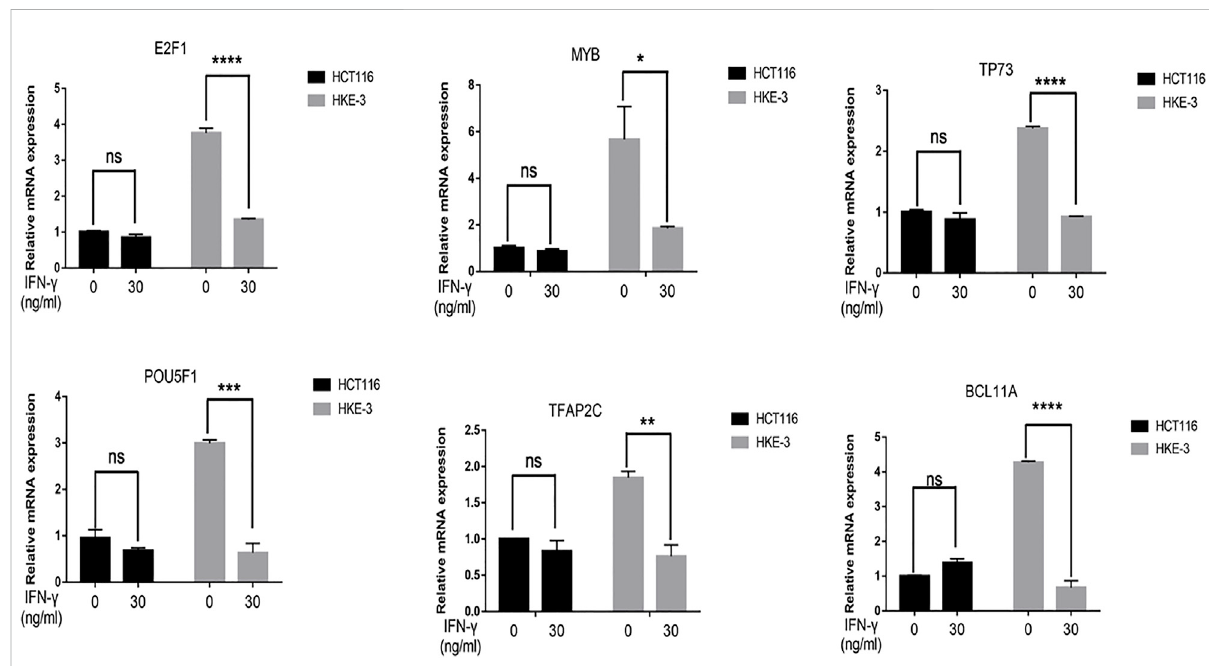
The mRNA expression of selected six transcription factors were downregulated by IFN- γ in HKE-3 cells. After being treated with IFN- γ , the mRNA expression of six transcription factors in HCT116 or HKE-3 cells was detected by RT-PCR analysis. * p < 0.05, ** p < 0.01, *** p < 0.001, and **** p < 0.0001 vs. no IFN- γ